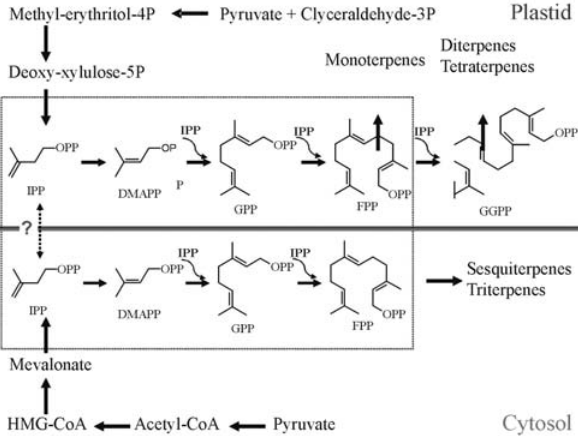
Figure 1 - General scheme of the biosynthesis of different terpene classes. The precursor IPP is biosynthesized in two different pathways, in plastids and cytosol, which involve similar reactions, but performed by specific enzymes in different compartments (dashed lines). In the cytosol, IPP will be the precursor of sequiterpenes and triterpenes, while monoterpenes, diterpenes and tetraterpenes are formed in plastids. HMG-CoA = hydroxymethyl glutaryl-CoA; IPP = isopentenyl pyrophosphate; DMAPP = dimethylallyl pyrophosphate; GPP = geranyl pyrophosphate; FPP = farnesyl pyrophosphate; GGPP = geranyl-geranyl pyrophosphate; GFPP = geranyl-farnesyl